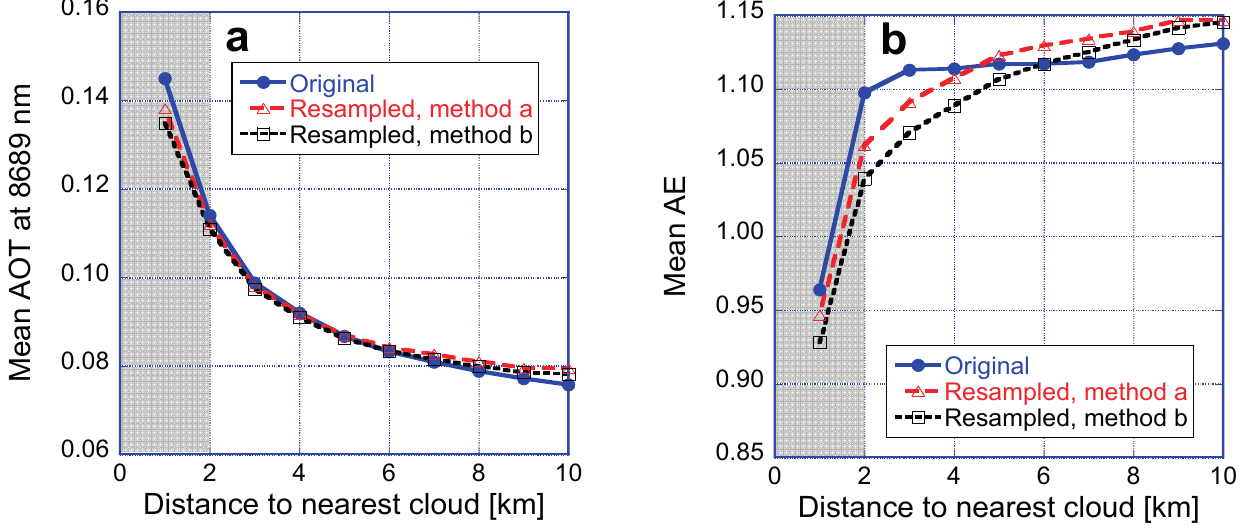
Figure 5. Near-cloud changes in ( a ) AOT and ( b ) AE, when data from all CFs is combined in various ways. Blue (original) : all data; Red (method a) : At all distance bins, the CF distribution is resampled to a uniform distribution ranging from 0 to 0.6; Green (method b) : At all distance bins, the CF distribution is resampled to the overall CF distribution. All QA flags are used to screen the data except for the straylight